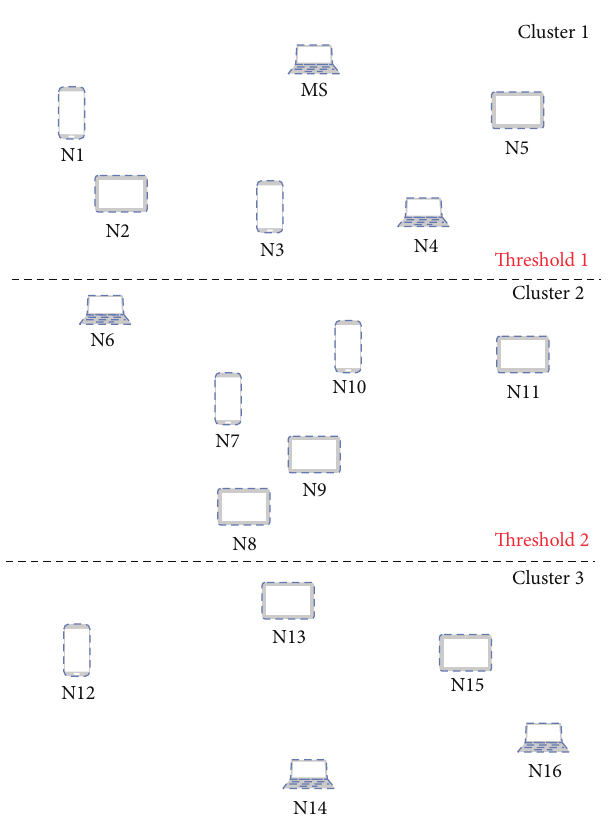
Figure 2: Distance clustering construction in our